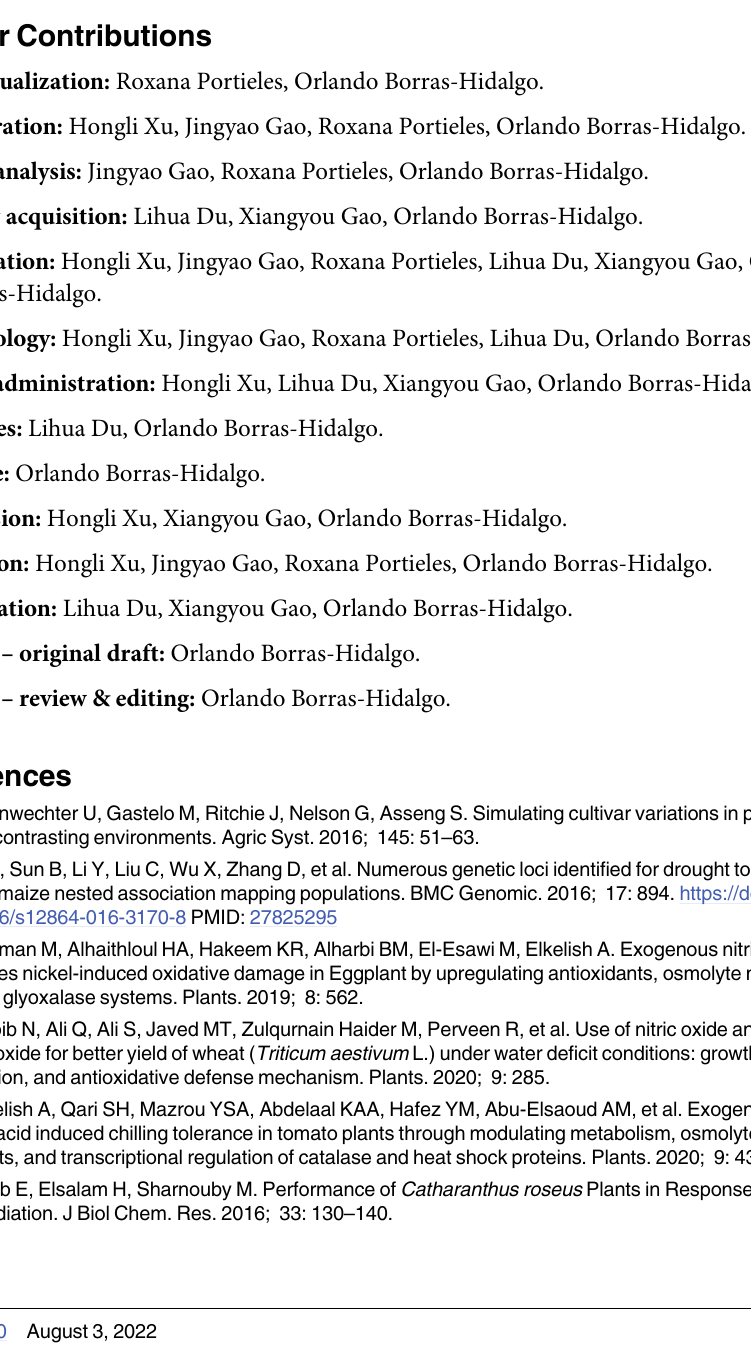
S2 Table. Evaluation of the effect of LB broth medium on Arabidopsis and tobacco growth